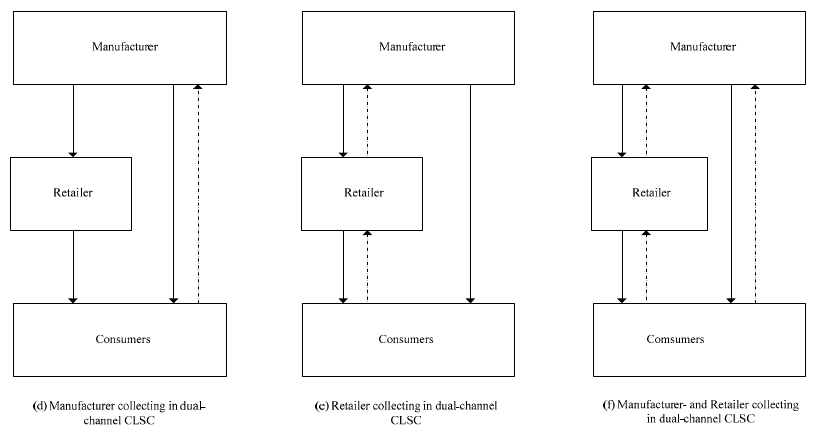
Figure 2. Three single-channel CLSC models.